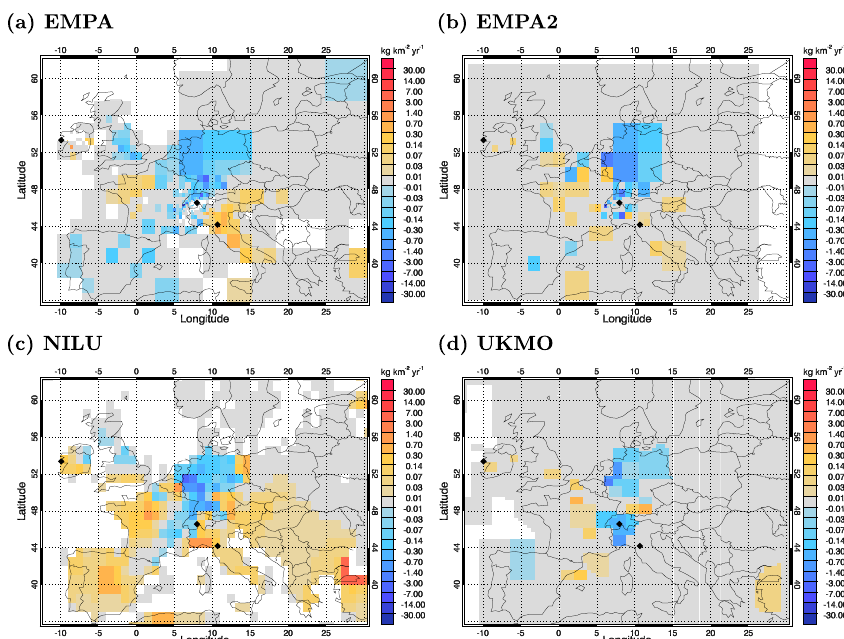
Figure 8. Posterior–prior SF 6 emission differences (experiment